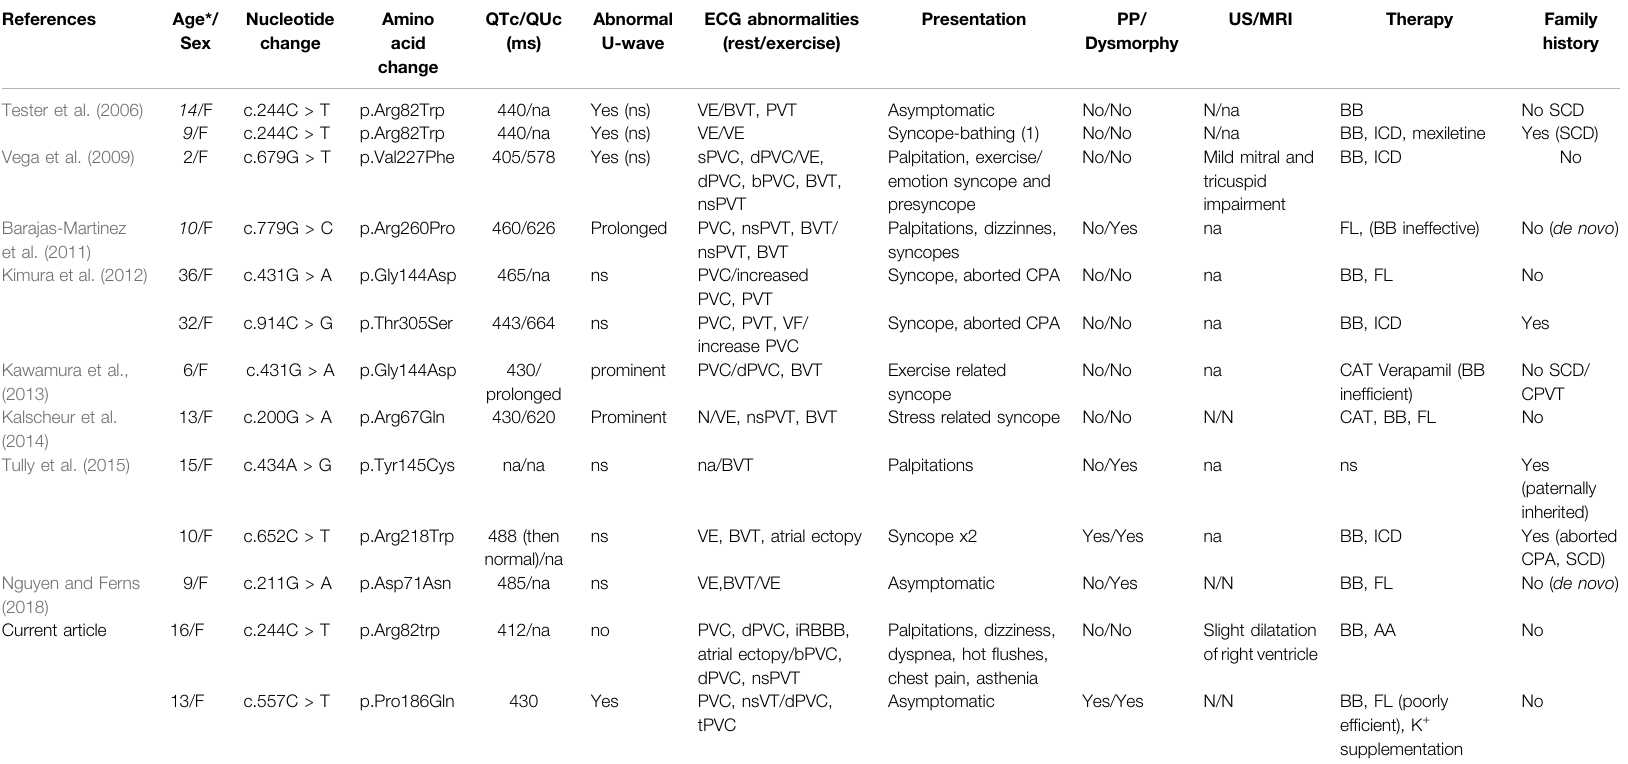
TABLE 1 | Clinical and genotype characteristics of KCNJ2 mutation-carrying patients with ventricular arrhythmia diagnosed as CPVT in the